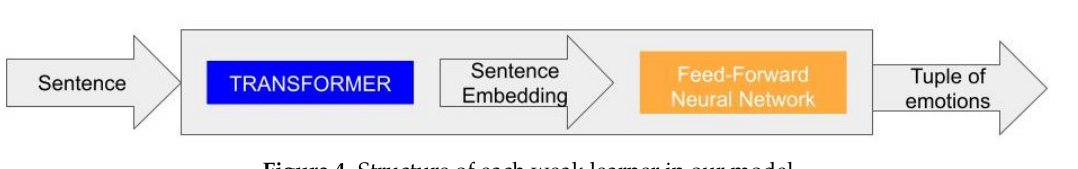
Figure 4. Structure of each weak learner in our